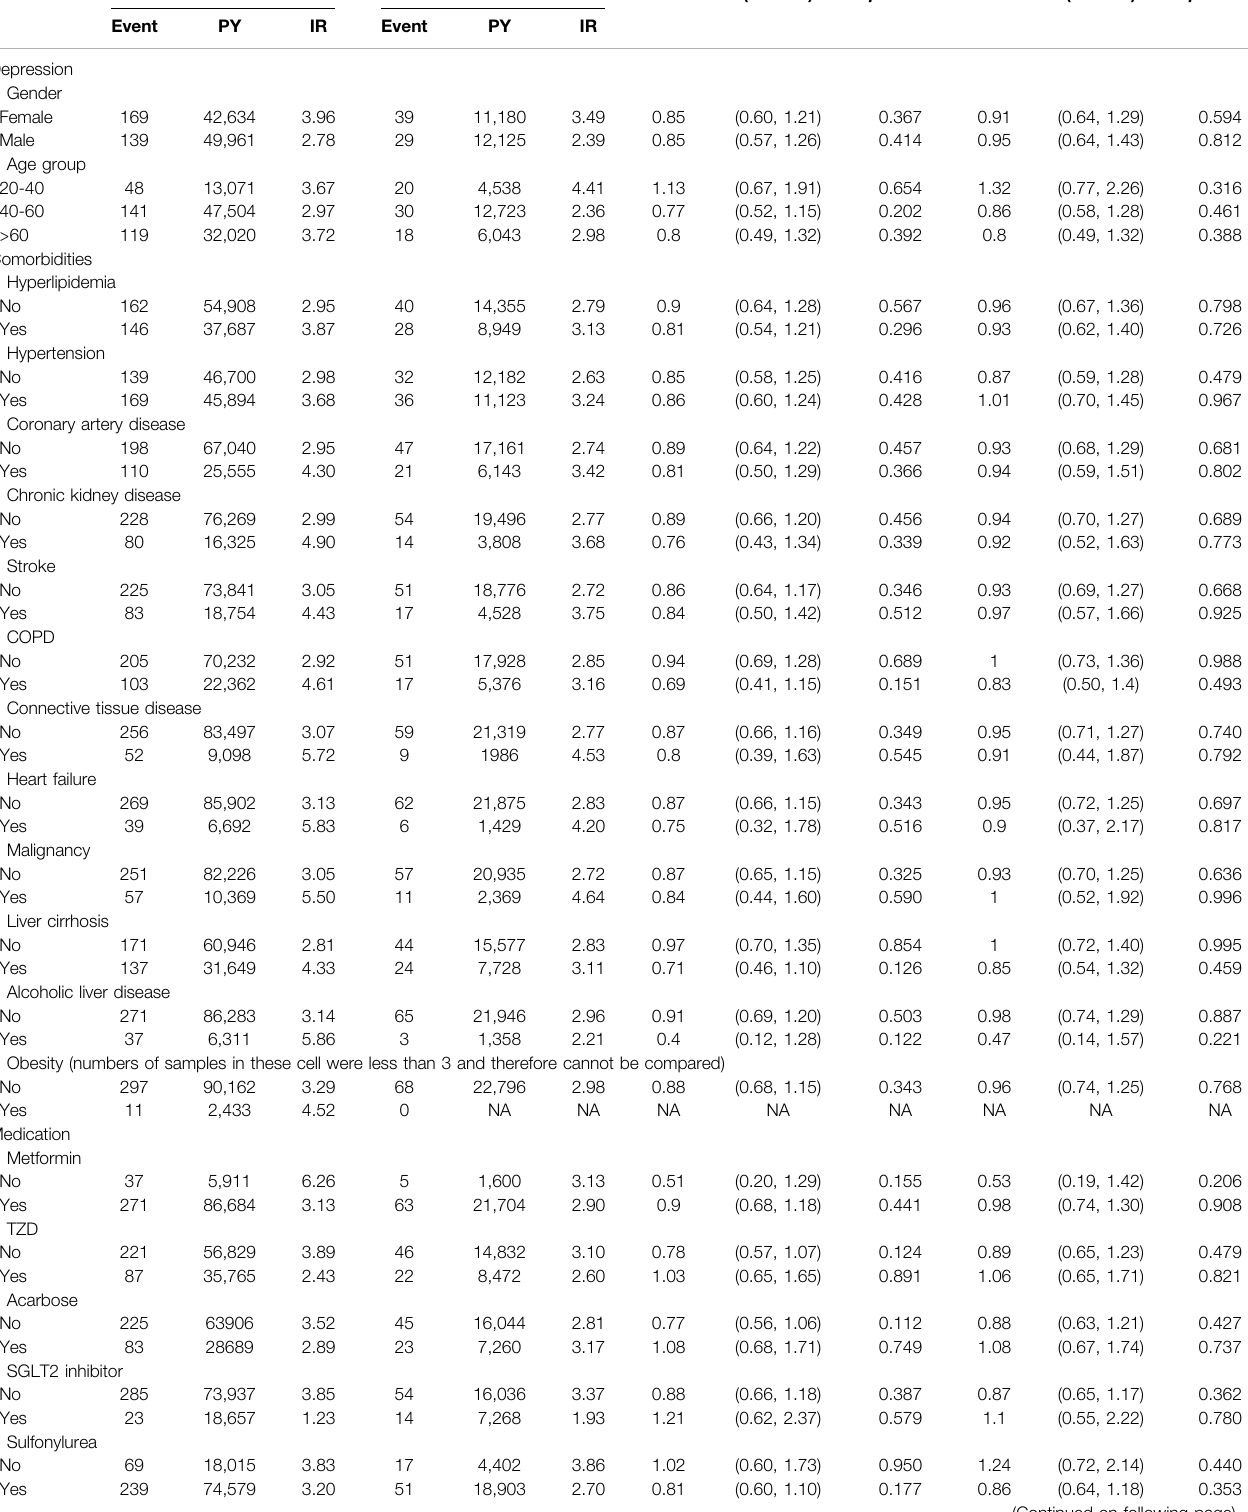
TABLE 4 | Factors associated with depression incidence in diabetes patients with/without GLP1-RA: subgroup analysis.